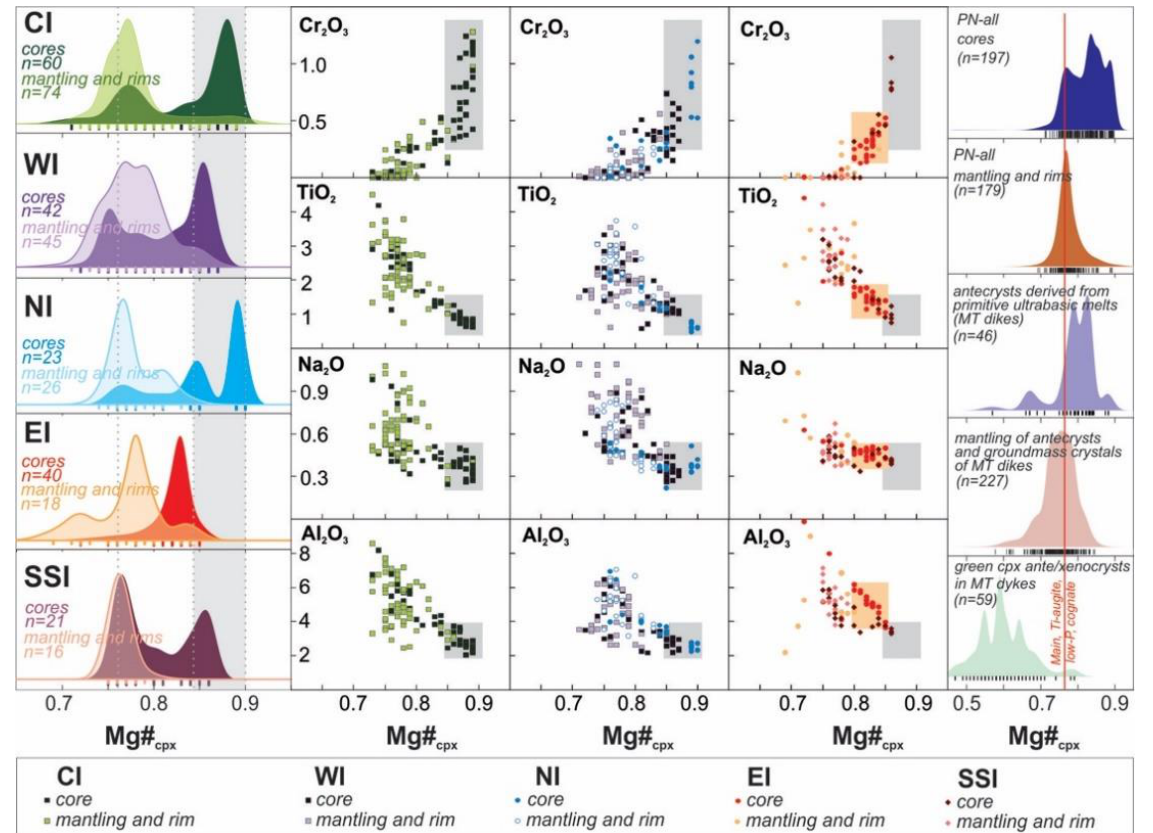
Figure 4. Clinopyroxene compositions of the Ponte Nova mafic – ultramafic alkaline massif. Kernel density estimates (KDEs; bandwidth = 0.01) of clinopyroxene Mg# distribution for each main intrusion of the massif indicate one peak of lower Mg# more compatible with Ti-augite compositions (gray dashed line) and one peak with higher Mg# compatible with diopside relict cores (gray bar). Interestingly, the KDE of Mg# cpx for PN antecrysts are very similar to that found for antecrysts from the nearby Mantiqueira Range lamprophyre and alkali basalt dikes, as well as the KDEs for PN mantling and rims are very similar to that found for Ti-augite mantling, rims and matrix crystals for the cited nearby